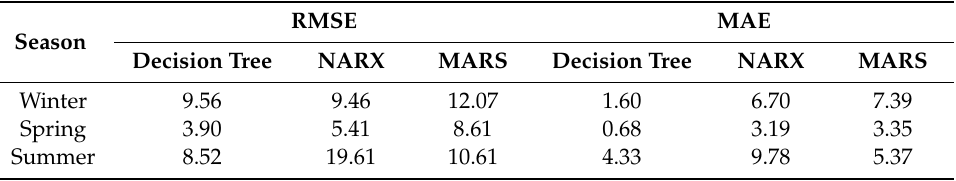
Table 5. Accuracy of model based on test data.